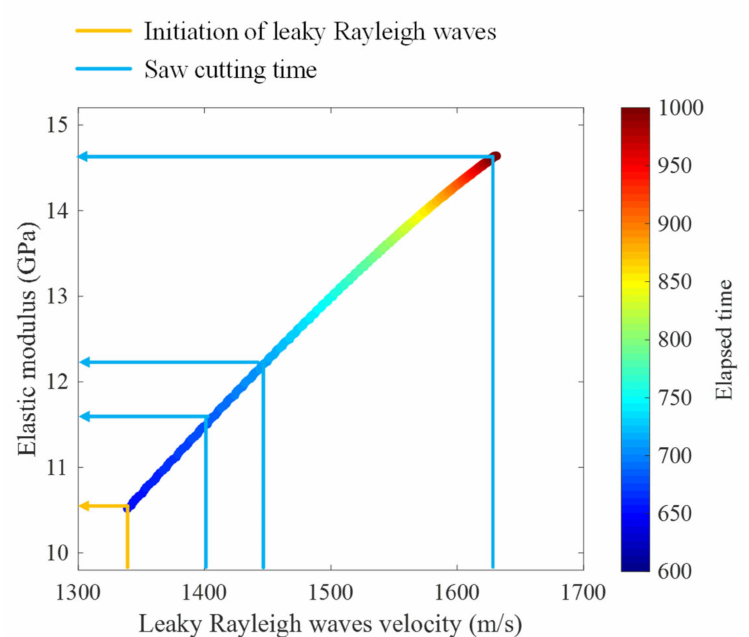
Figure 10. Elastic modulus of concrete computed using measured leaky Rayleigh wave responses. Elapsed time is presented in a